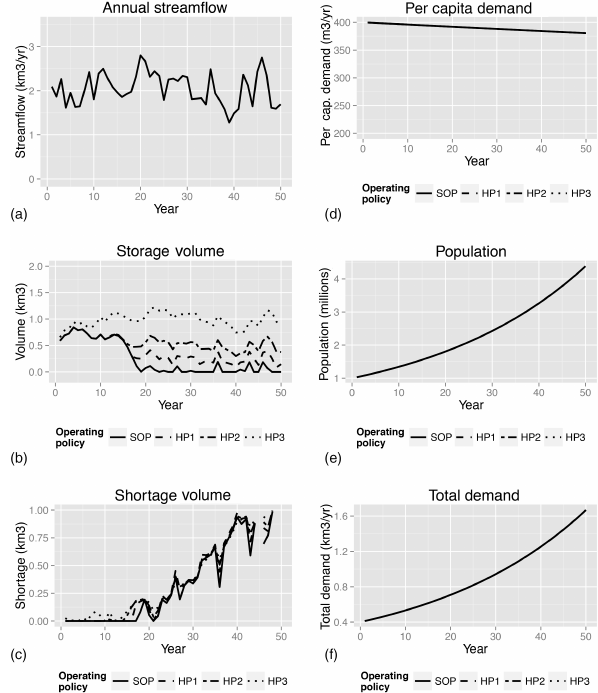
Figure 8. Model results, trial 3: (a) annual streamflow, (b) reser- voir storage volume, (c) public shortage awareness, (d) per capita demand, (e) annual city population, (f) total demand.